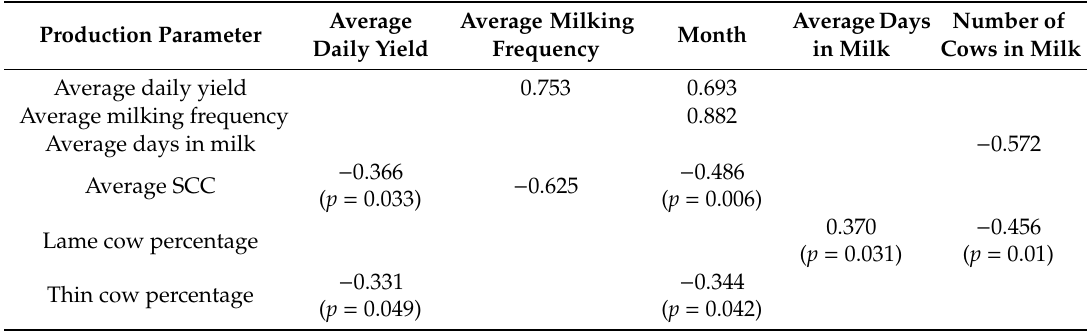
Table 1. Significant correlations 1 between production parameters for all lactating cows (101 ± 6) on the study farm from November 2016 to December 2018.